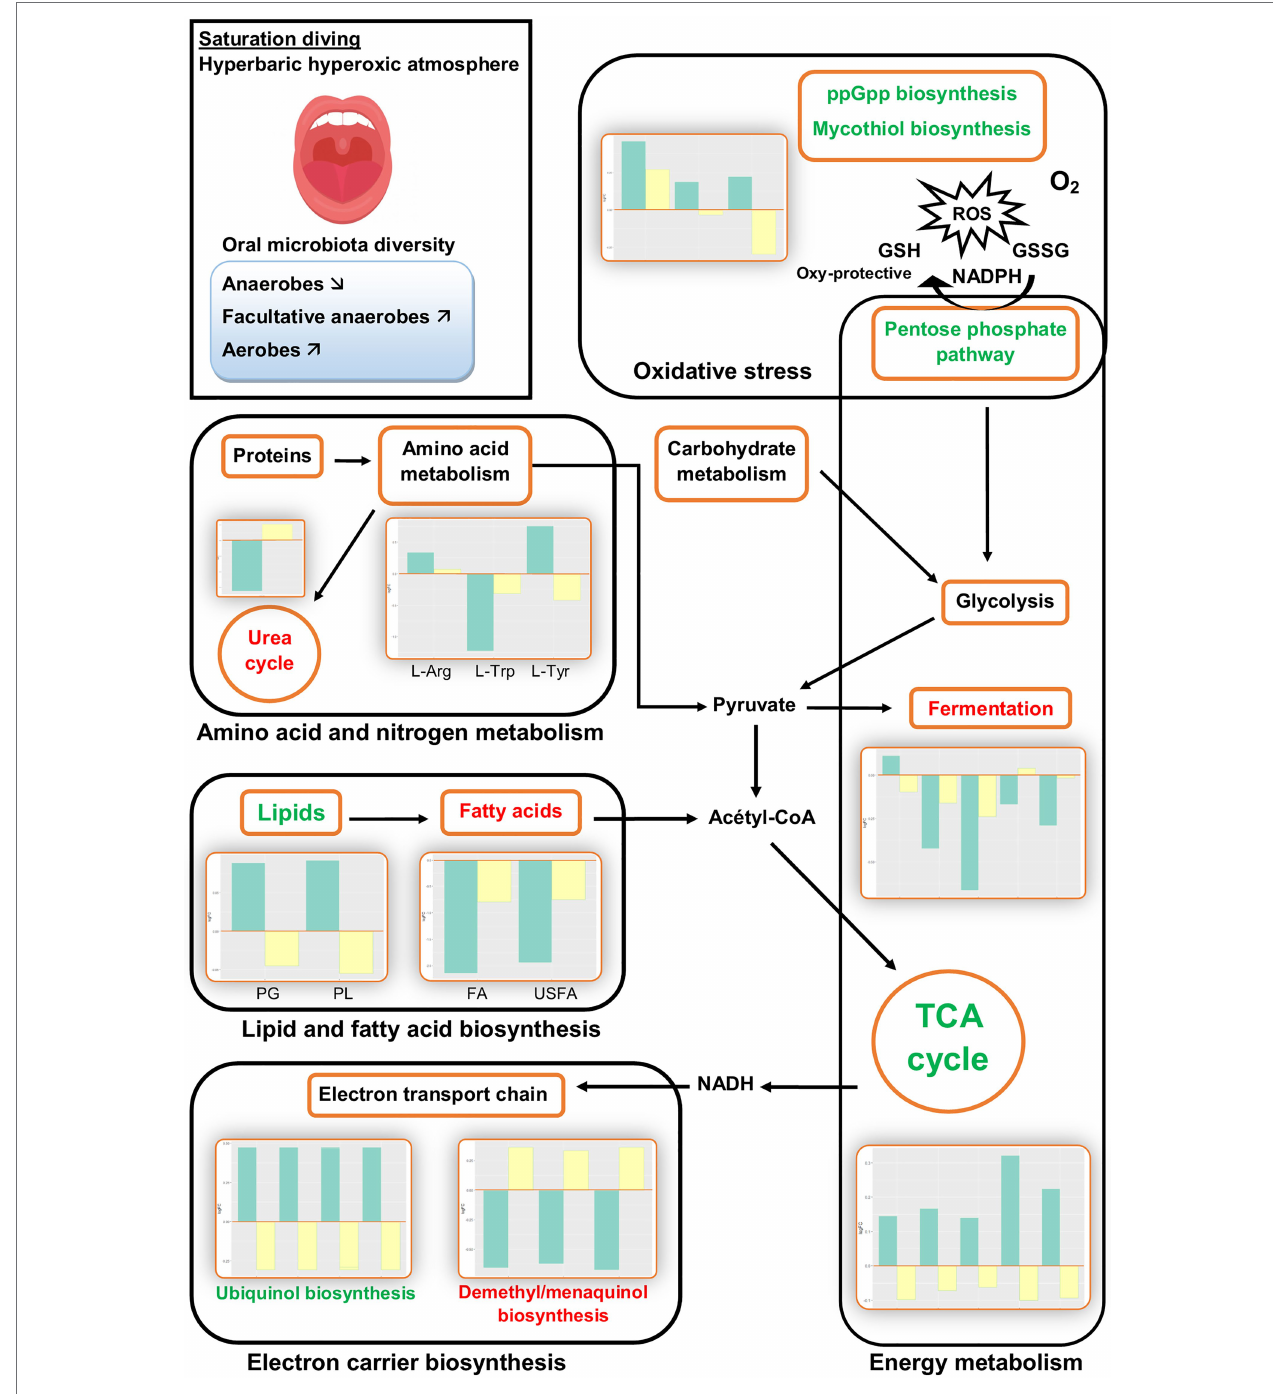
FIGURE 2 | Illustrative overview of inferred changes in oral bacterial metabolic pathways during hyperbaric heliox saturation. The bar plots show log2 fold change from paired t tests (means relative to baseline, n = 23): green = after 2 days of heliox saturation; yellow = after decompression. For each pathway, the overall direction of change is indicated by green (more active) or red (less active) text. L-Arg, L-arginine biosynthesis ( p = 0.0205); L-Trp, L-tryptophane degradation ( p = 0.0066); L-Tyr, L-tyrosine degradation ( p = 0.0337); PG, phosphatidylglycerol ( p = 0.0066); PL, phospholipid ( p = 0.0066); FA, fatty acids ( p = 0.0233); and USFA, unsaturated fatty acids ( p =